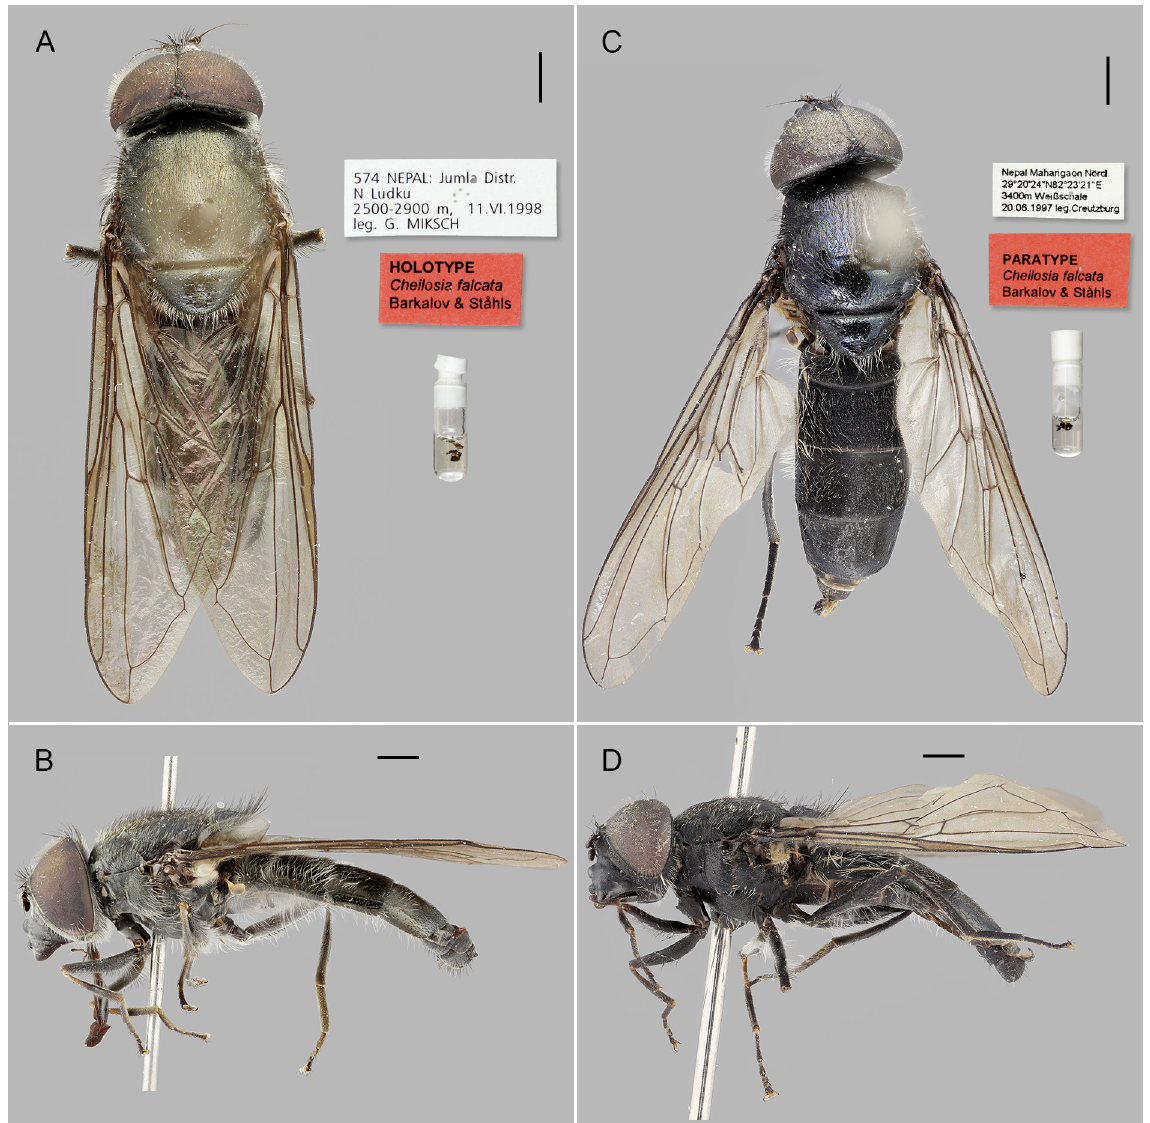
Fig. 21. Cheilosia ( Cheilosia ) falcata sp. nov. A–B . Holotype, ♂ (SMNS); dorsal and lateral views. C–D . Paratype, ♂ (IBSJW/NME); dorsal and lateral views. Photo: Pekka Malinen, FMNH Luomus. Scale bars = 1